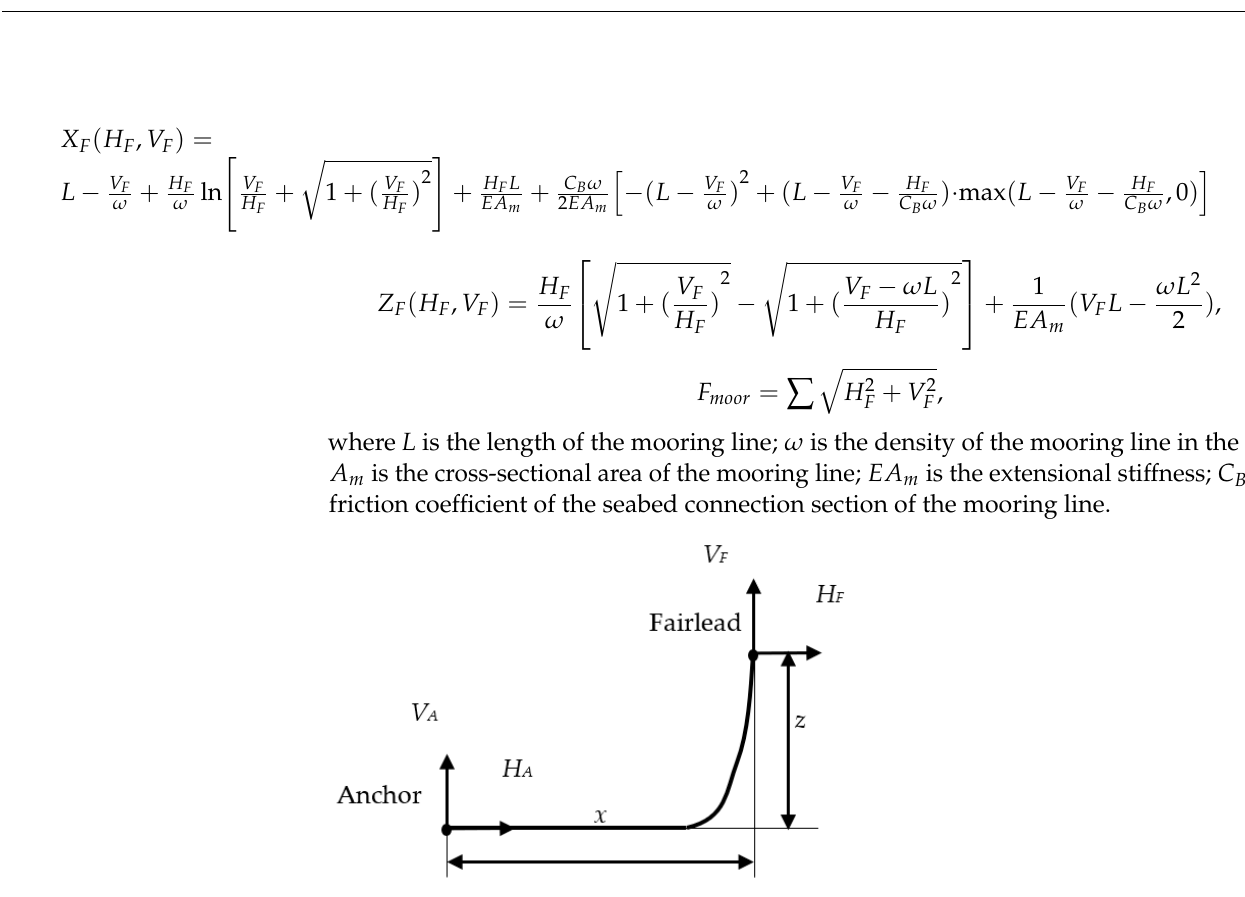
Figure 3. Mooring system model.